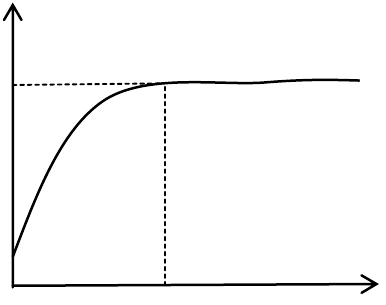
Figure 2. Semivariogram and its parameters Semivariogram has three basic parameters (Figure 2): nugget, sill and range. The nugget is an estimate of variance at distance (or lag) zero, which may be interpreted as a measure of variability inside the pixel cell. The semivariance is a